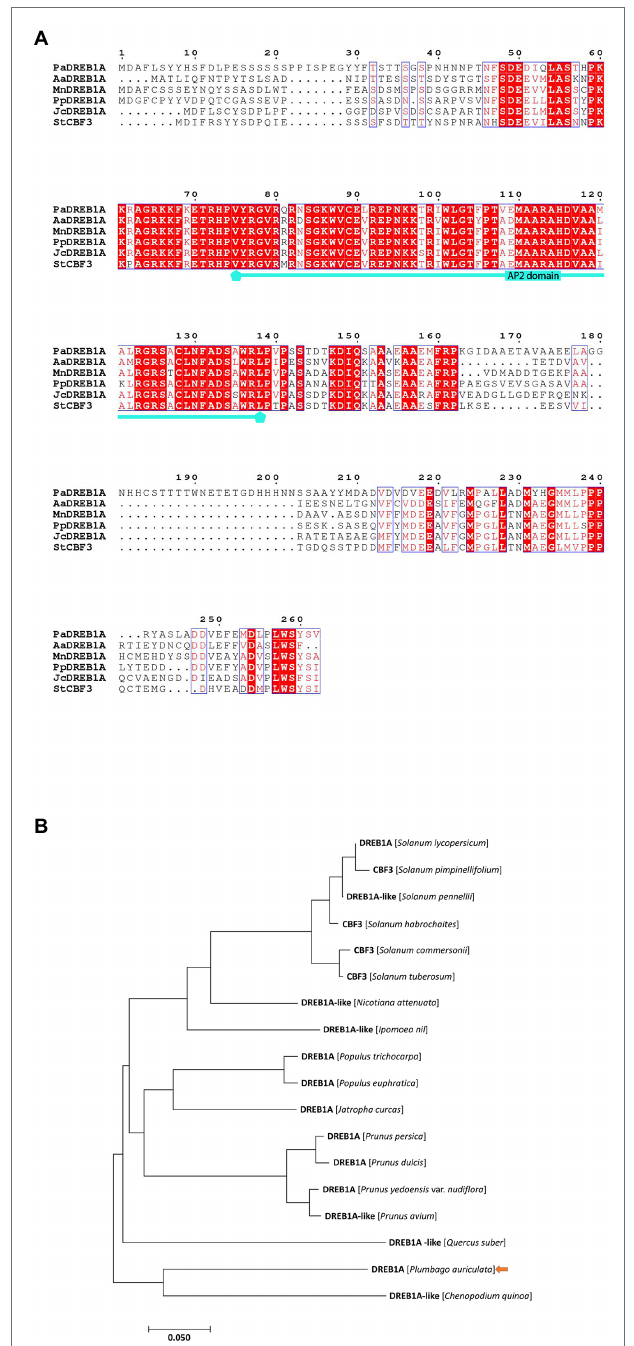
FIGURE 4 | Sequence alignment and phylogenetic analysis of PaDREB1A . (A) Multiple sequence alignment of PaDREB1A . (B) Phylogenetic tree constructed using the neighbor-joining method. PaDREB1A is indicated by an arrow.